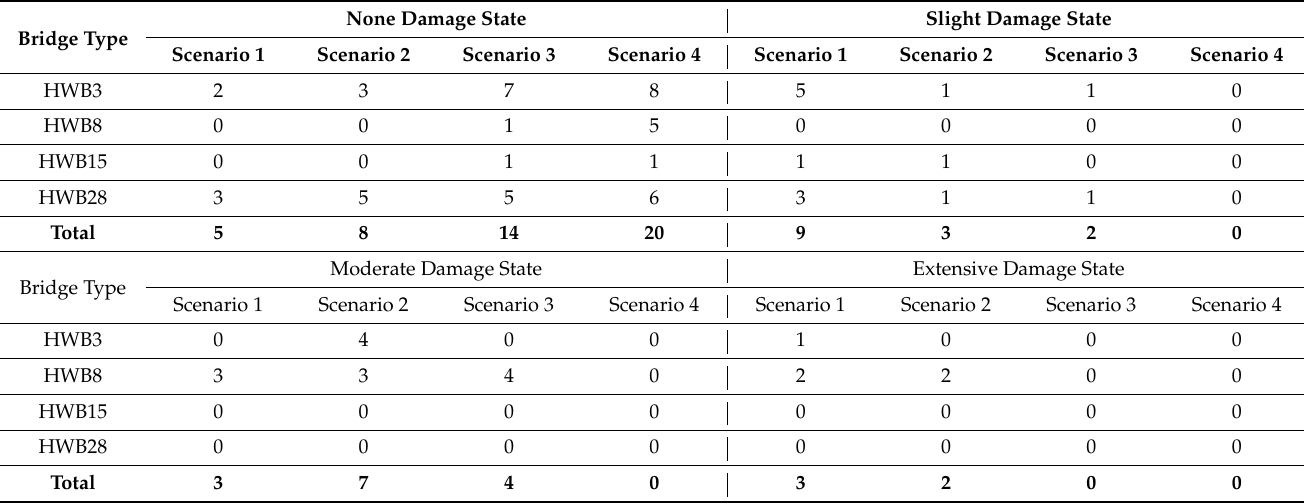
Table 8. Damage state distribution of all four scenarios.